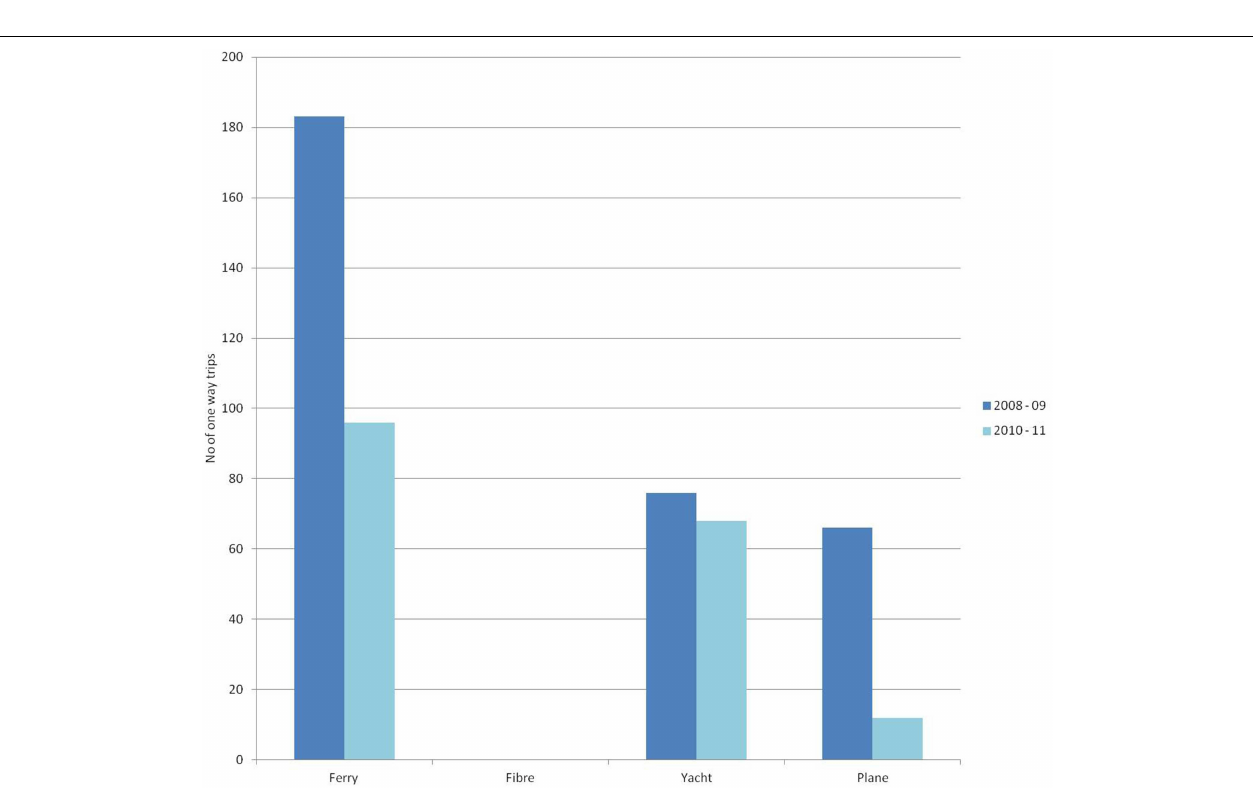
Frontiers in Marine Science |